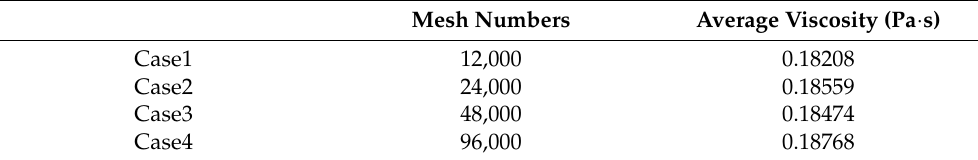
Table 4. Average viscosity at the outlet under different mesh numbers.